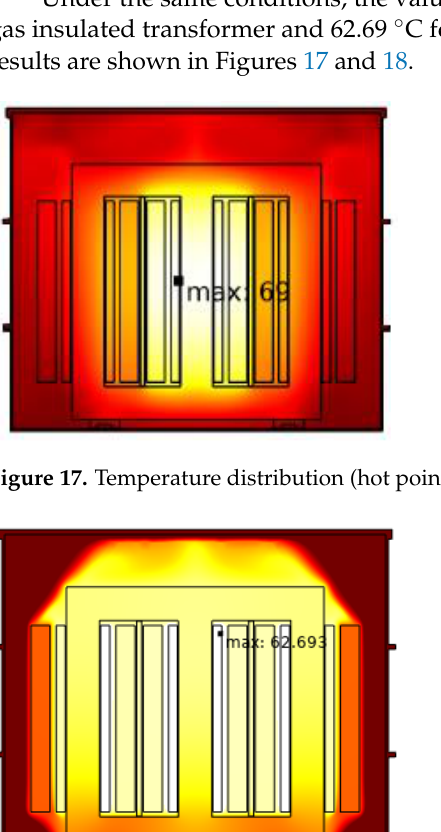
Figure 18. Temperature distribution (hot points) inside the tank for oil insulated transformer. Figure 19 shows the gas velocity at t = 2 h when the system is close to steady state. The heating of the gas by the HV-LV windings causes a decrease in density and the gas rises. Gas at the top is displaced and circulates, establishing a convection pattern, with the gas velocity higher at the top than the bottom.